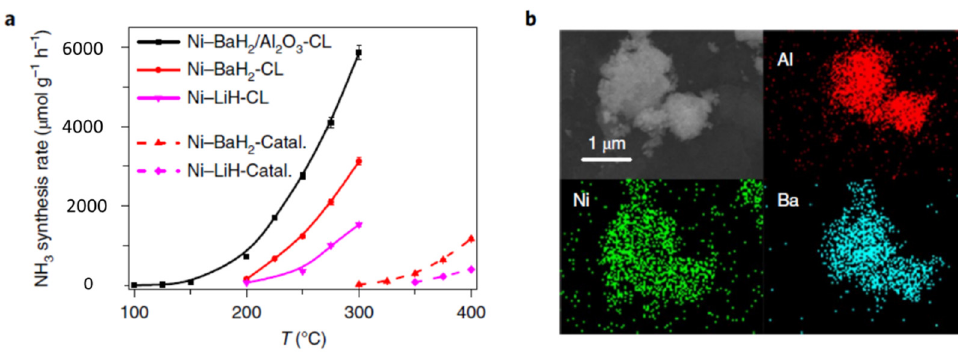
Figure 12. Ni-BaH 2 and Ni-LiH performance in NH 3 production. ( a ) Temperature-dependent production rates in chemical looping (CL) and thermo-catalytic processes (Catal). ( b ) Microscope images and elemental maps of spent Ni-BaH 2 /Al 2 O 3 [74].